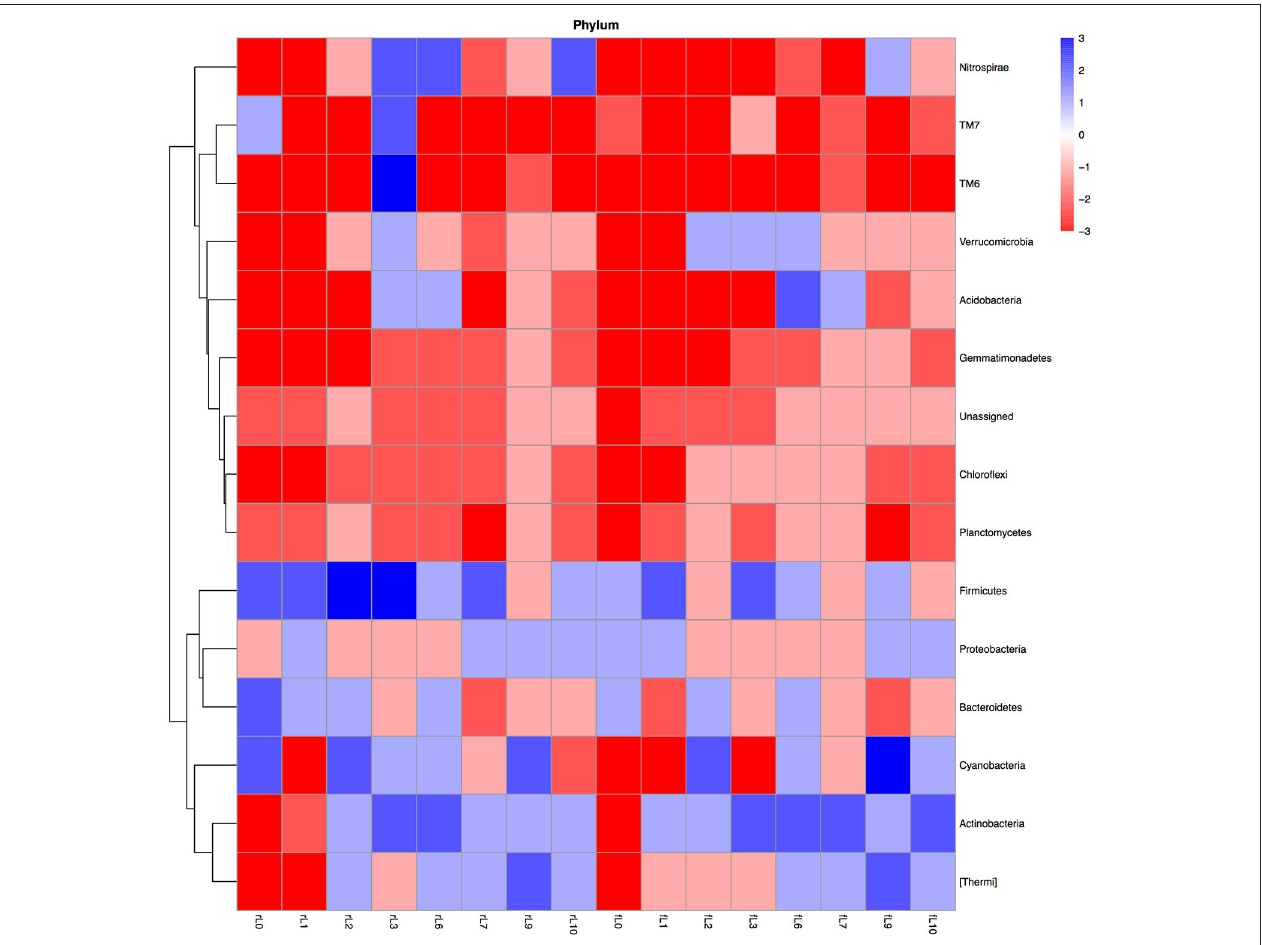
FIGURE 5 | Heatmap of the ratio between the relative abundance of the different bacterial phyla in the unamended soil vs. the soil amended with maize plantlets or its neutral detergent fiber (NDF) for soil never flooded (rL0) flooded once (rL1), twice (rL2), trice (rL3), six (rL6), seven (rL7), nine (rL9), or ten times (rL10). The ratio was calculated as: [(relative abundance of the bacterial group in the maize amended soil—relative abundance of the bacterial group in the unamended soil)/relative abundance of the bacterial group in the unamended soil]. Heatmaps with the ratios were made in R programming language using the libraries pheatmap and gplots. The ratios were categorized with value − 5: ratio ≤ − 0.99, value − 4: ratio > − 0.99 ≤ − 0.96, value − 3: ratio > − 0.96 and ≤ − 0.80, value − 2: ratio > − 0.80 ≤ − 0.50, value − 1: ratio > − 0.50 > 0, value 0: ratio = 0, value 1: ratio > 0 and < 1, value 2: ratio ≥ 1 and < 4, value 3: ratio ≥ 4 and < 24, value 4: ratio ≥ 24 and < 99, value 5: ratio ≥